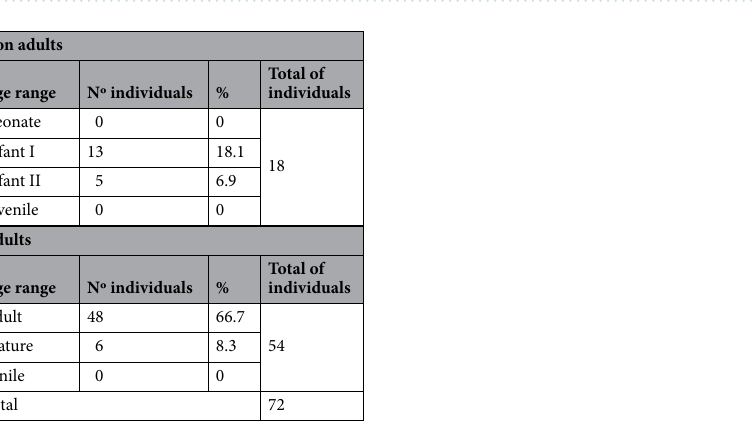
Table 3. Distribution by age group.